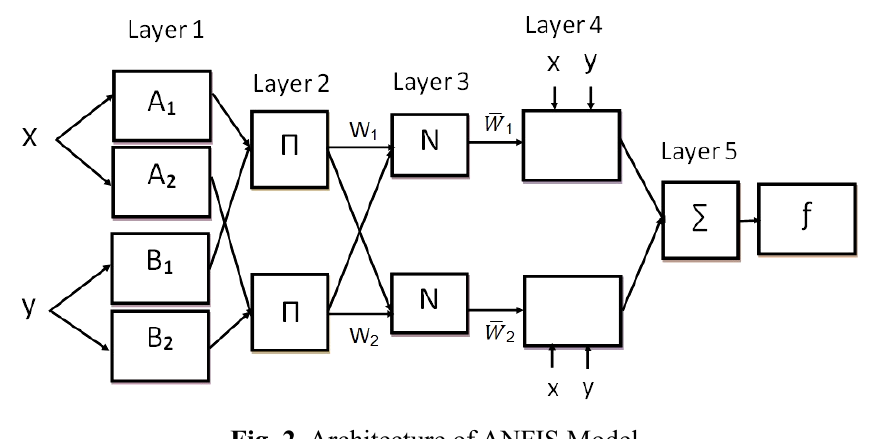
Fig. 2. Architecture of ANFIS